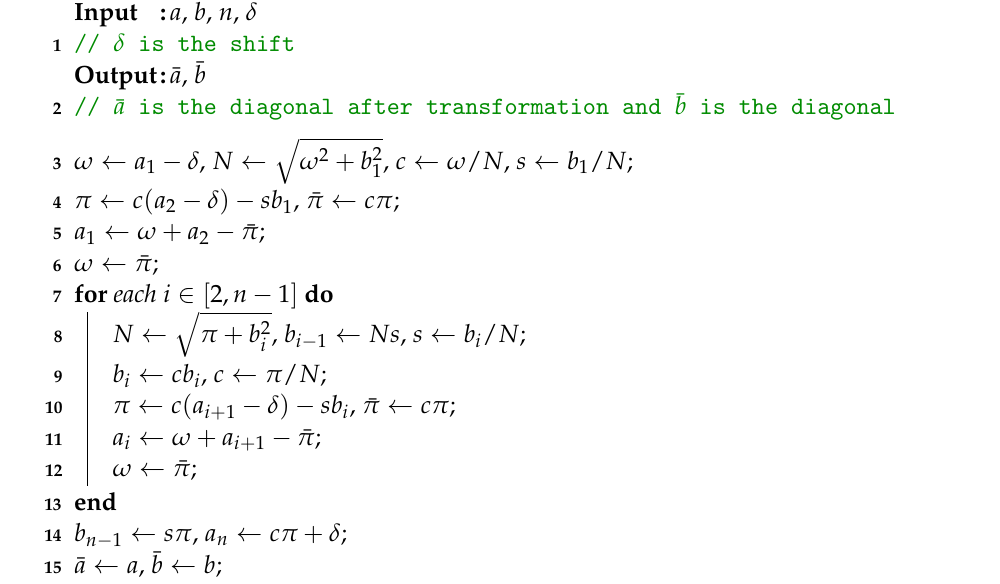
Algorithm 4: QR iteration with the implicit shift.